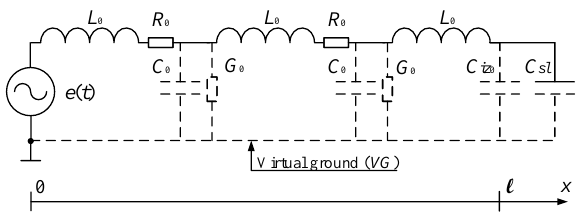
Fig. 7. Tesla coil equivalent two-wire scheme and coordinate reference